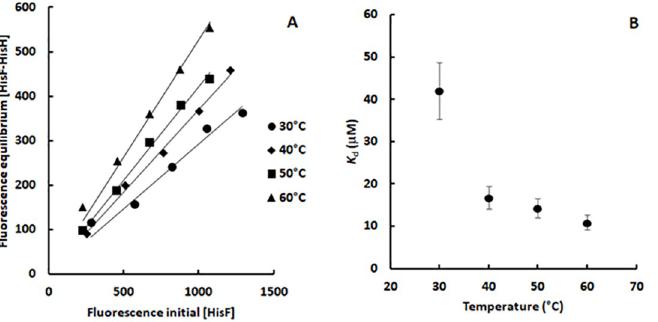
Fig 4. Determination of the dissociation constant of the HisF-HisH heterodimer at different temperatures. A) Effect of the initial HisF concentration ([ F 0 ]) on the HisF-HisH heterodimer concentration in the equilibrium ([ F H]). Fluorescence readings at 321 nm were used as proxy for the HisF and the heterodimer concentration. Those data were extracted from Fig 3A and 3C, respectively. The linear correlation coefficients ( R 2 ) are 0.96, 0.99, 0.99 and 0.98 at 30˚C, 40˚C, 50˚C and 60˚C, respectively. The slopes are 0.29, 0.37, 0.42 and 0.53 at 30˚C, 40˚C, 50˚C and 60˚C, respectively. B) Effect of the temperature on the dissociation constant of the HisF-HisH heterodimer. The K d were calculated based on the slopes of the lines shown in panel A. More details on Material and methods.